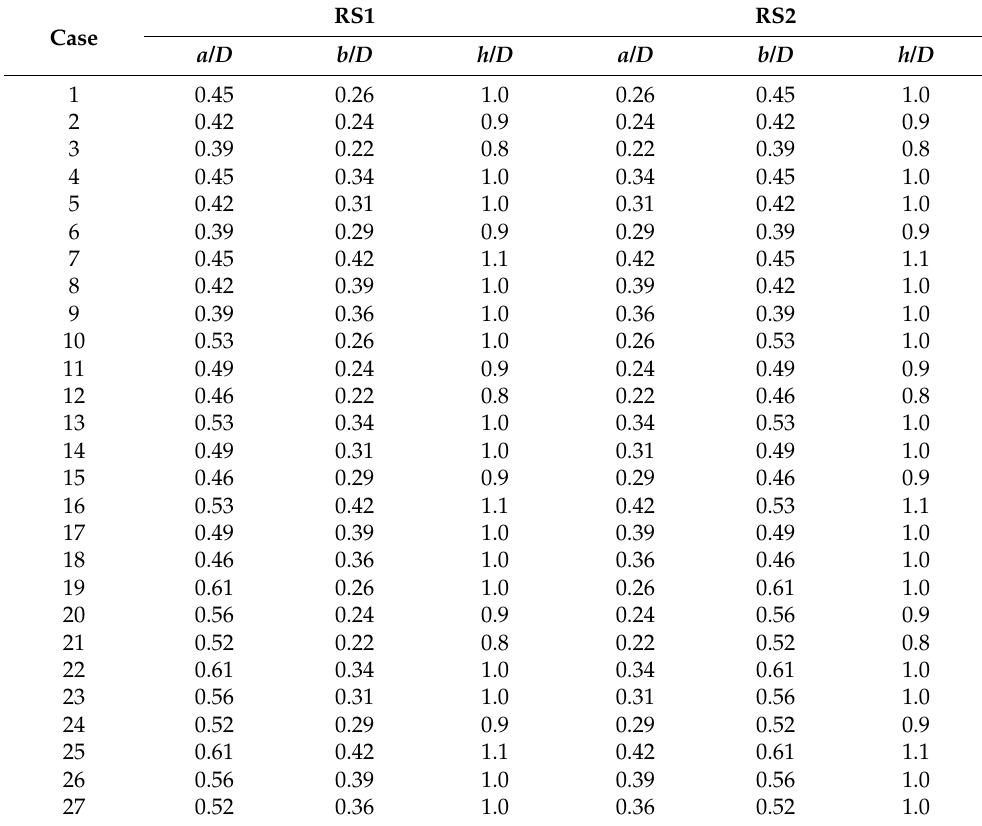
Table 2. Design of experiment.